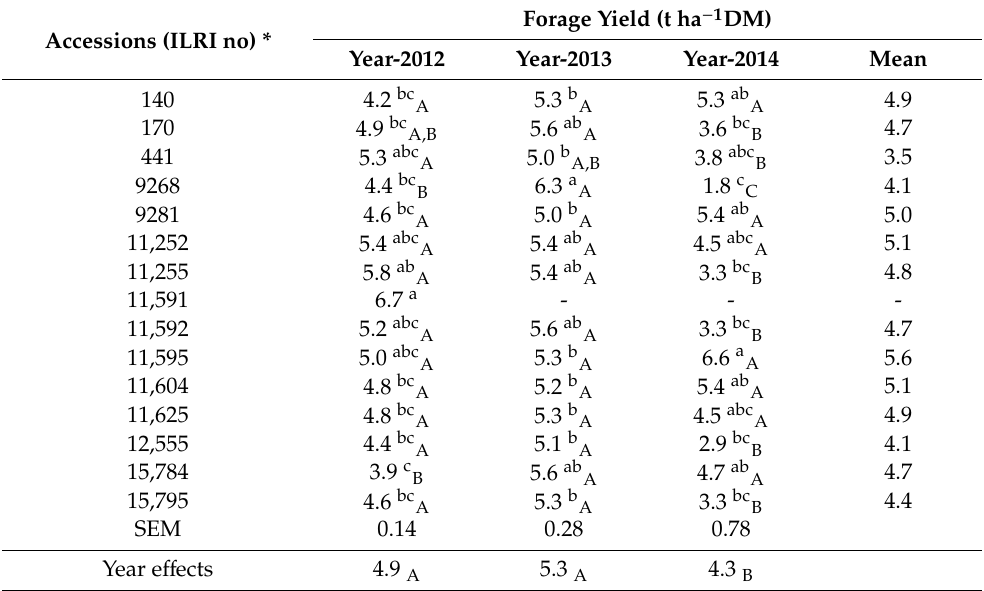
Table 4. Forage yield of di ff erent Stylosanthes scabra accessions evaluated in climatic condition of Pretoria over three years 2012, 2013 and